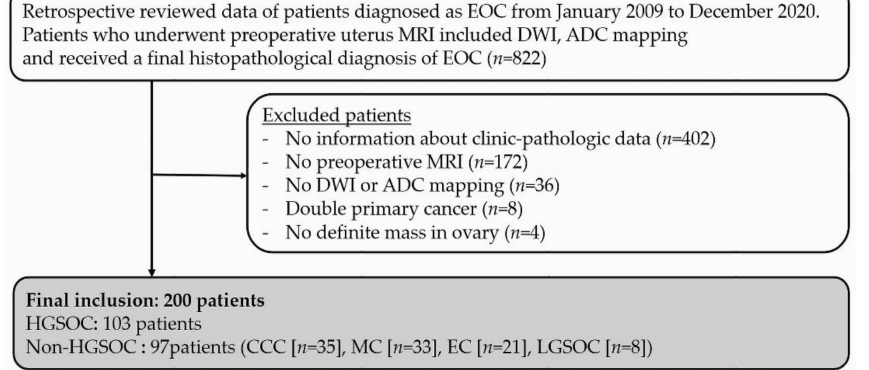
Figure 1. Flowchart for including patients in the study. EOC, epithelial ovarian cancer; DWI, diffusion-weighted imaging; HGSOC, high-grade serous ovarian cancer; MC, mucinous carcinoma; EC, endometrioid cancer; CCC, clear-cell carcinoma; LGSOC, low-grade serous ovarian